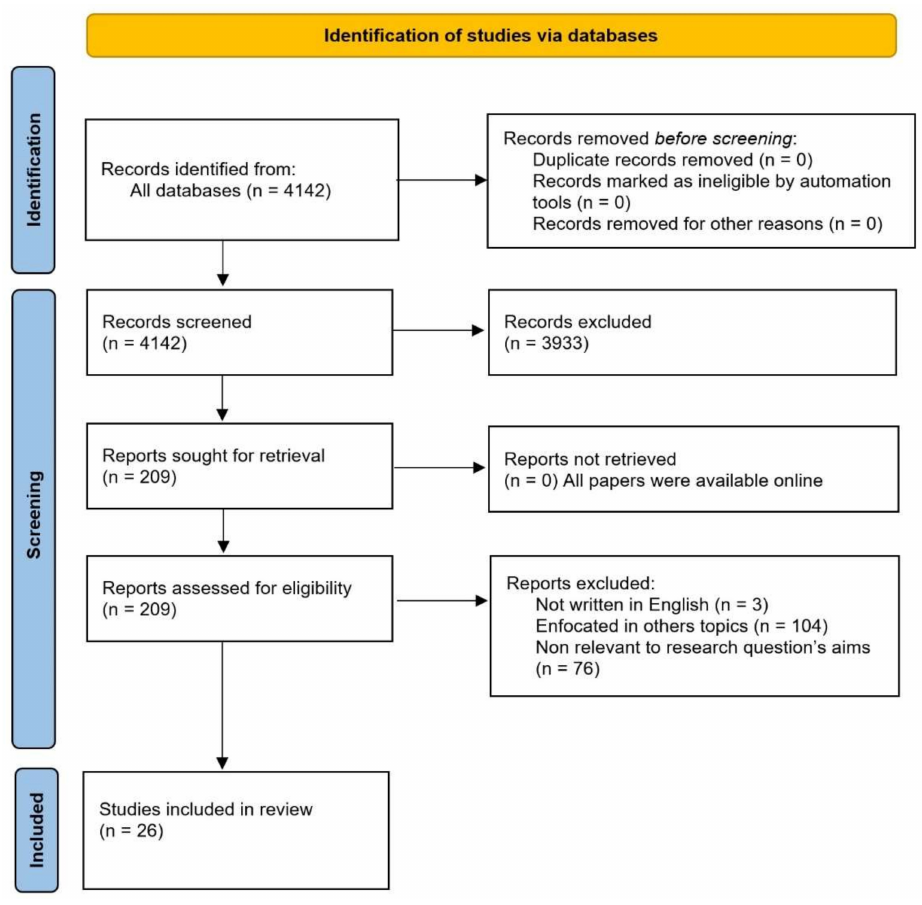
Figure 3. PRISMA Flow Diagram of the Search